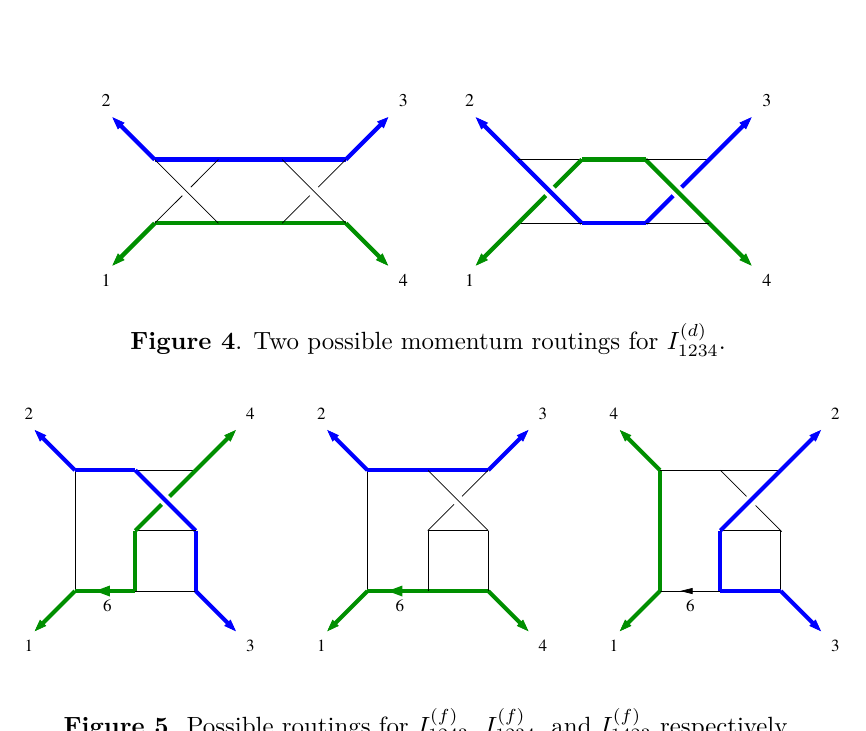
Figure 5 . Possible routings for I ( f )